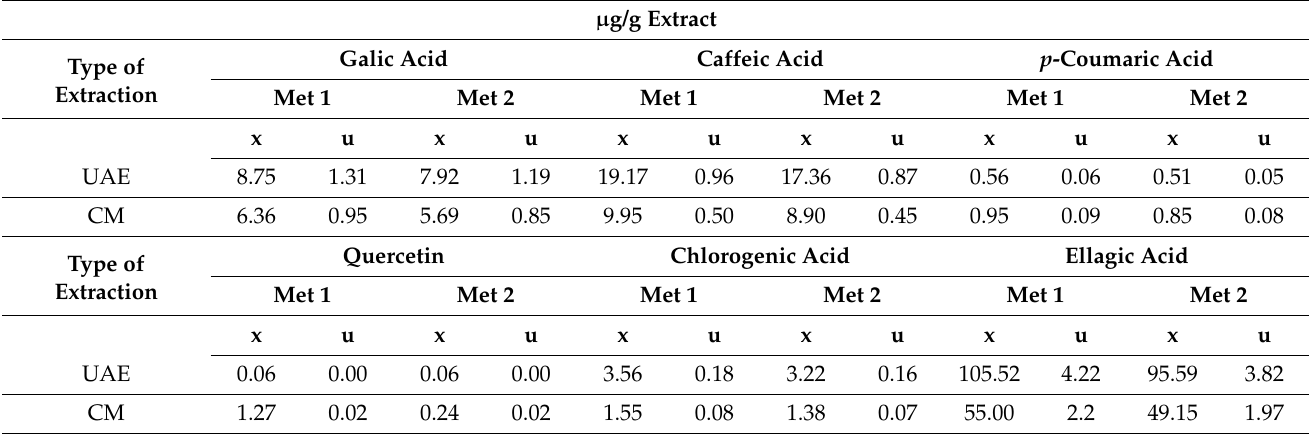
Table 5. Content of polyphenols in raspberry fruit pomace. µ g/g